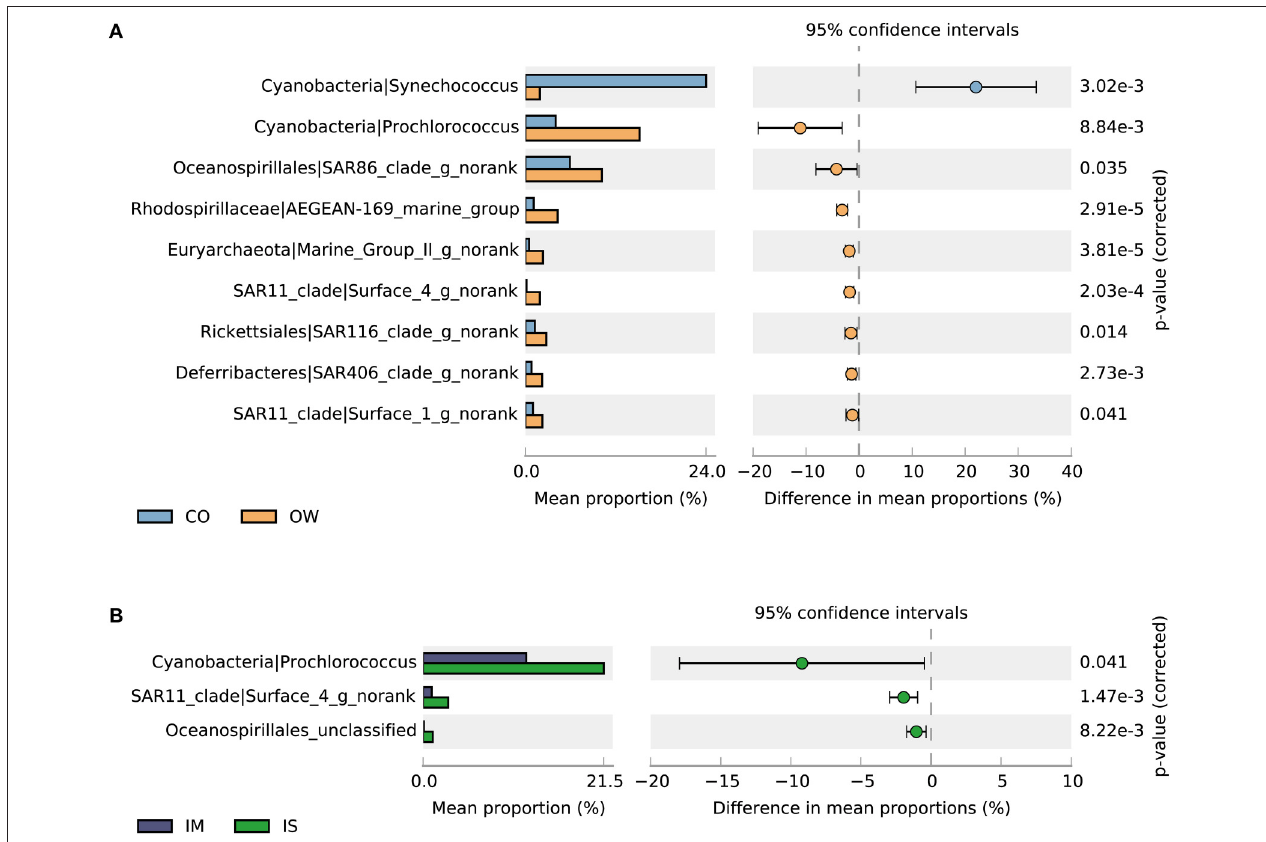
FIGURE 7 | Taxa showing significantly different relative abundances at genus level. (A) Coastal (CO) and open seawater (OW). (B) Open seawater from Indian Monsoon Gyre Province (IM, T3-T11) and Indian Subtropical Gyre Province (IS, T12-T15). Differences were considered significant if q < 0.05 and filtered for effect sizes (difference between proportions >